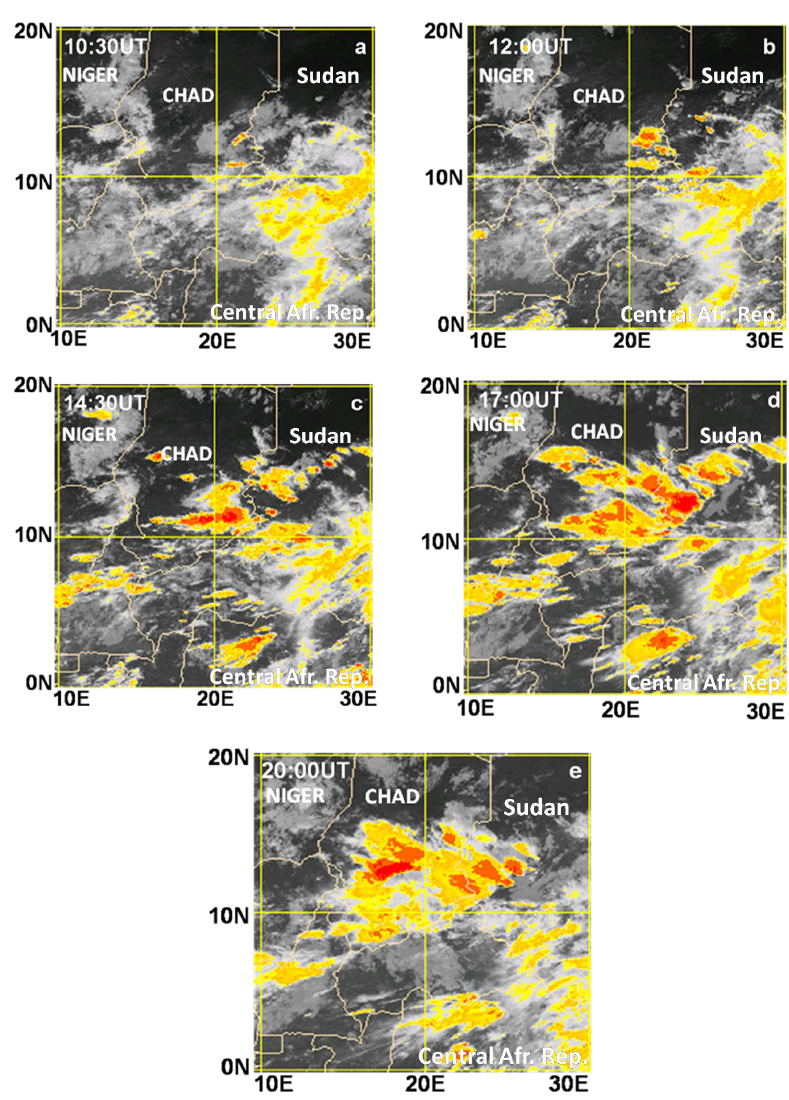
Fig. 2e Fig. 2. Meteosat Second Generation Infrared images in the 10 ◦ E to 30 ◦ E longitude range and in the 0 ◦ N to 20 ◦ N latitude range on